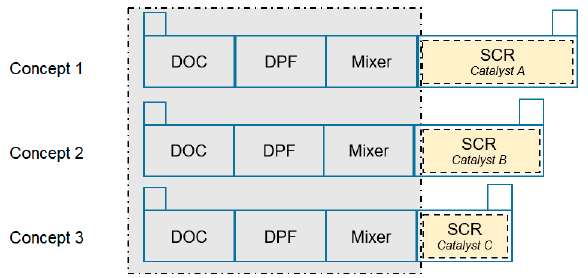
Figure 2. Parameter variation in an NRTC emission cycle.